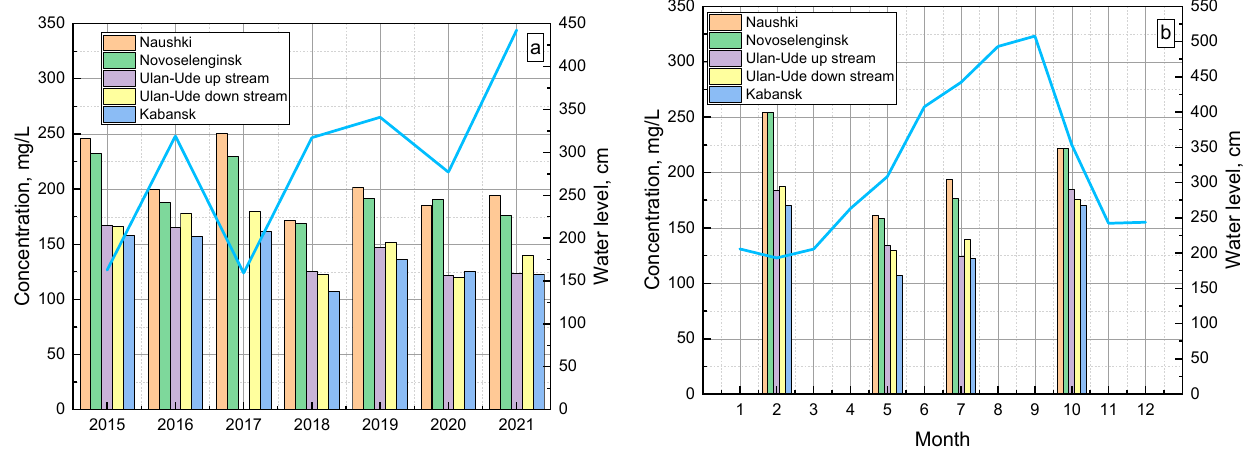
Figure 9. Spatiotemporal ( a ) and seasonal ( b ) changes in water salinity in the Selenga. Concentrations of major ions HCO 3 − , SO 42- , Cl − , Ca 2+ , Mg 2+ , Na + , and K + in the Selenga River water during 2015–2021 varied in the intervals (mg/L): 72 − 184; 6.3 − 17.8; 0.8 − 1.9; 17.4 − 41.2; 3.6 − 11.2; 4.3 − 9.4 and 1.0 − 2.1, respectively. The maximum concentrations of all com-